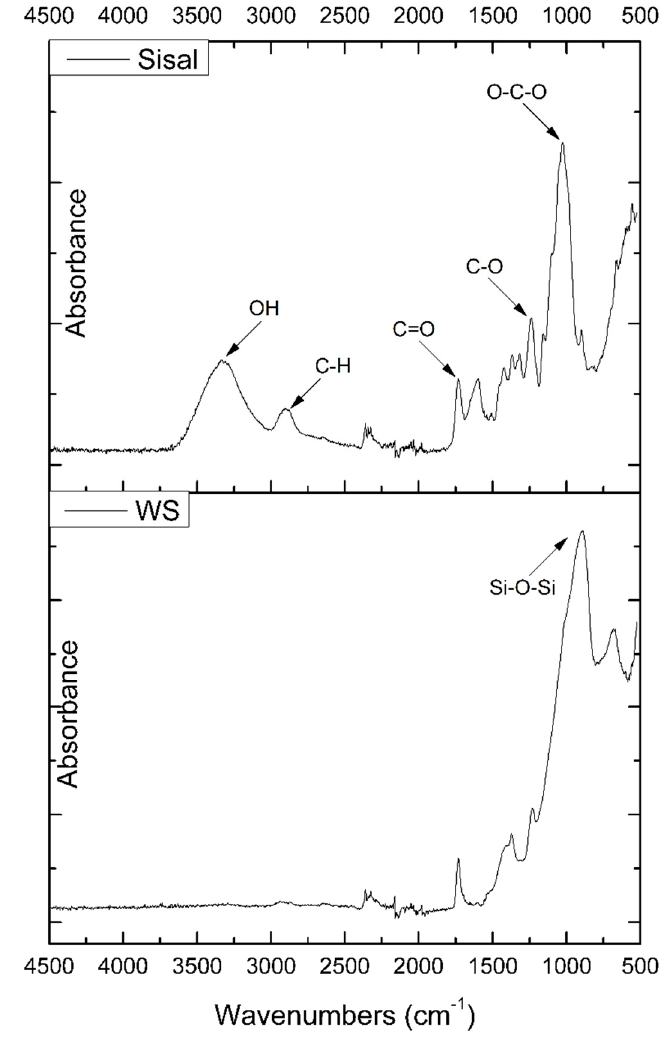
Figure 6. FTIR spectra of sisal and glass fiber (GF).